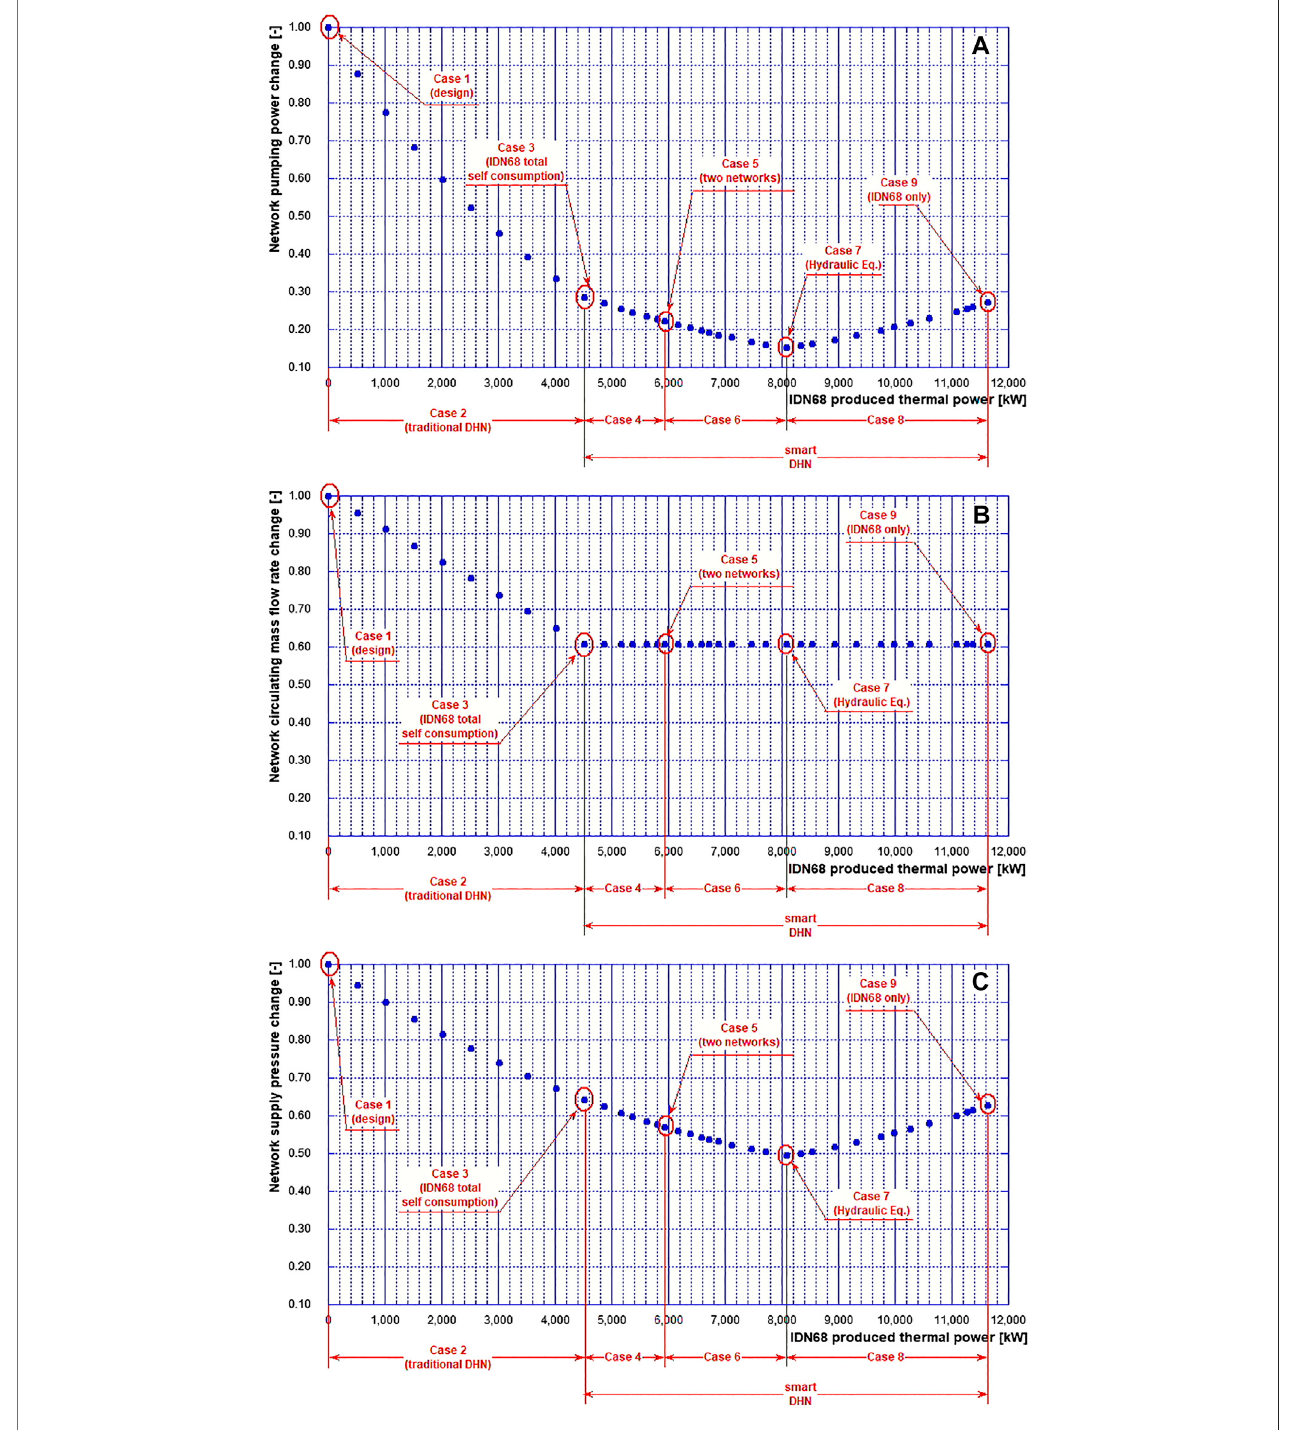
FIGURE8| Effect oftheprosumer-producedthermal power on thenetwork: (A) pumping power, (B) circulating mass fl owrate,and (C) supply pressure variation.